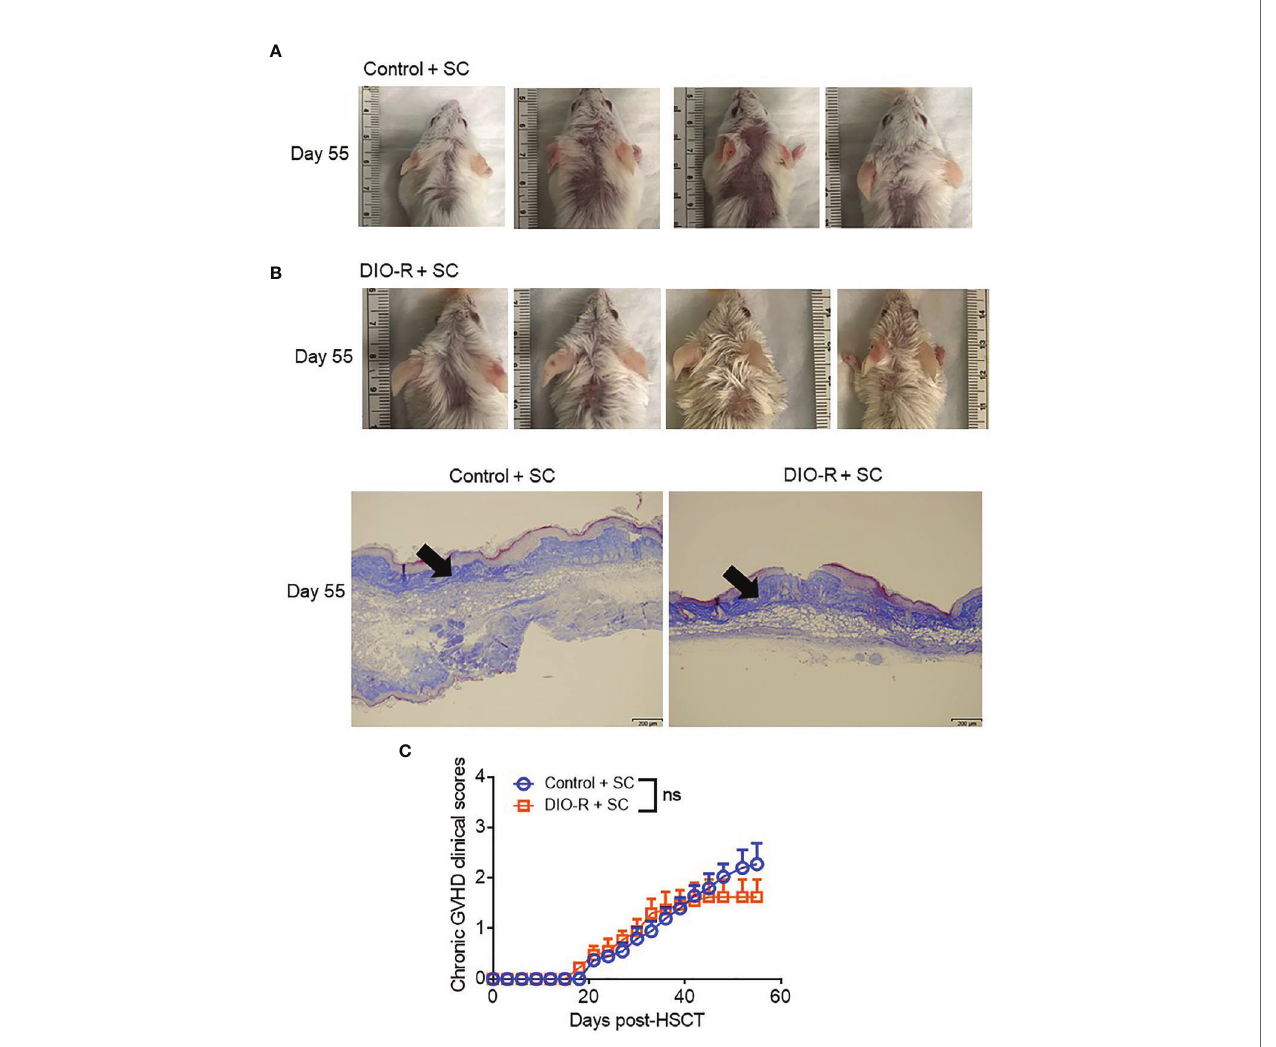
FIGURE 5 | (A) Representative images of sclerodermatous GVHD with alopecia at day 55 post-HSCT. (B) Representative photos of sclerodermatous GVHD with tissue fi brosis by Trichrome staining. The scale bar is 200 m m. Arrows indicate collagen deposition (blue). (C) Chronic GVHD clinical scores post-HSCT (n=4/group). Bar graphs depict mean ±s.e.m. Unpaired Student ’ s t test was used in (C) . NS, not signi fi